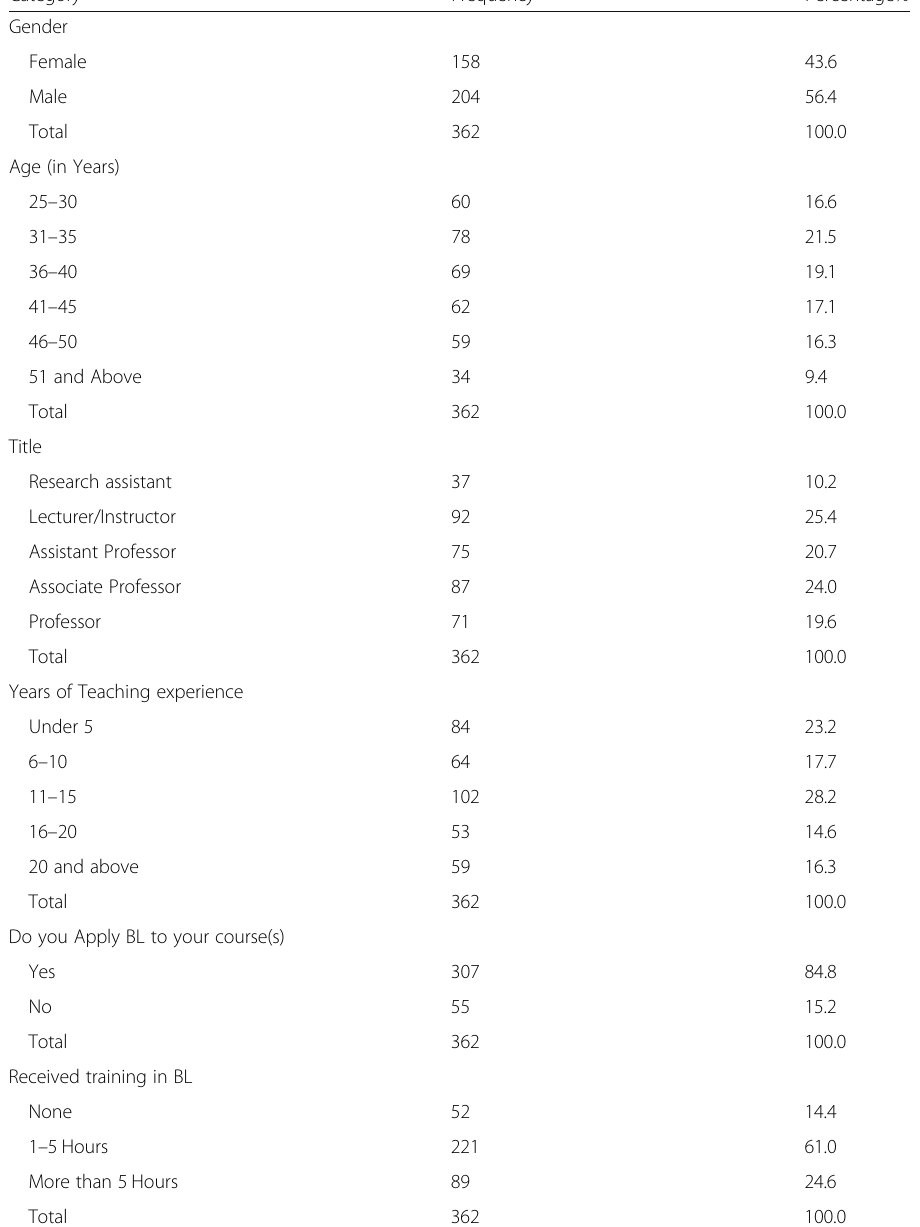
Table 2 The demographic characteristics of the sample